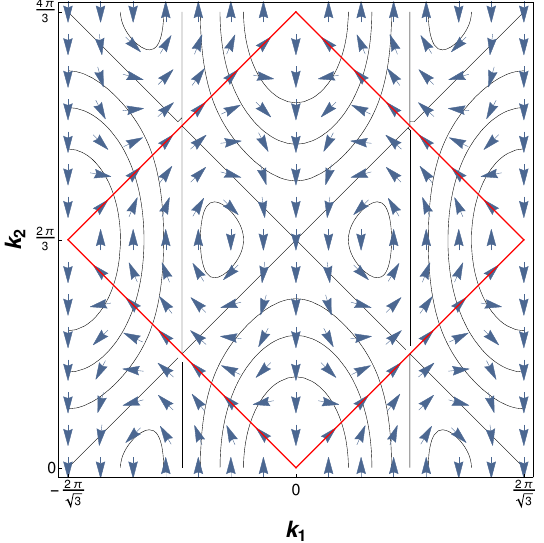
Figure 2. The circulation of the Berry vector potential corresponding to the occupied band of the full half filled tight-binding model in the reciprocal space with visible vortex-like structures around the position of the nodal